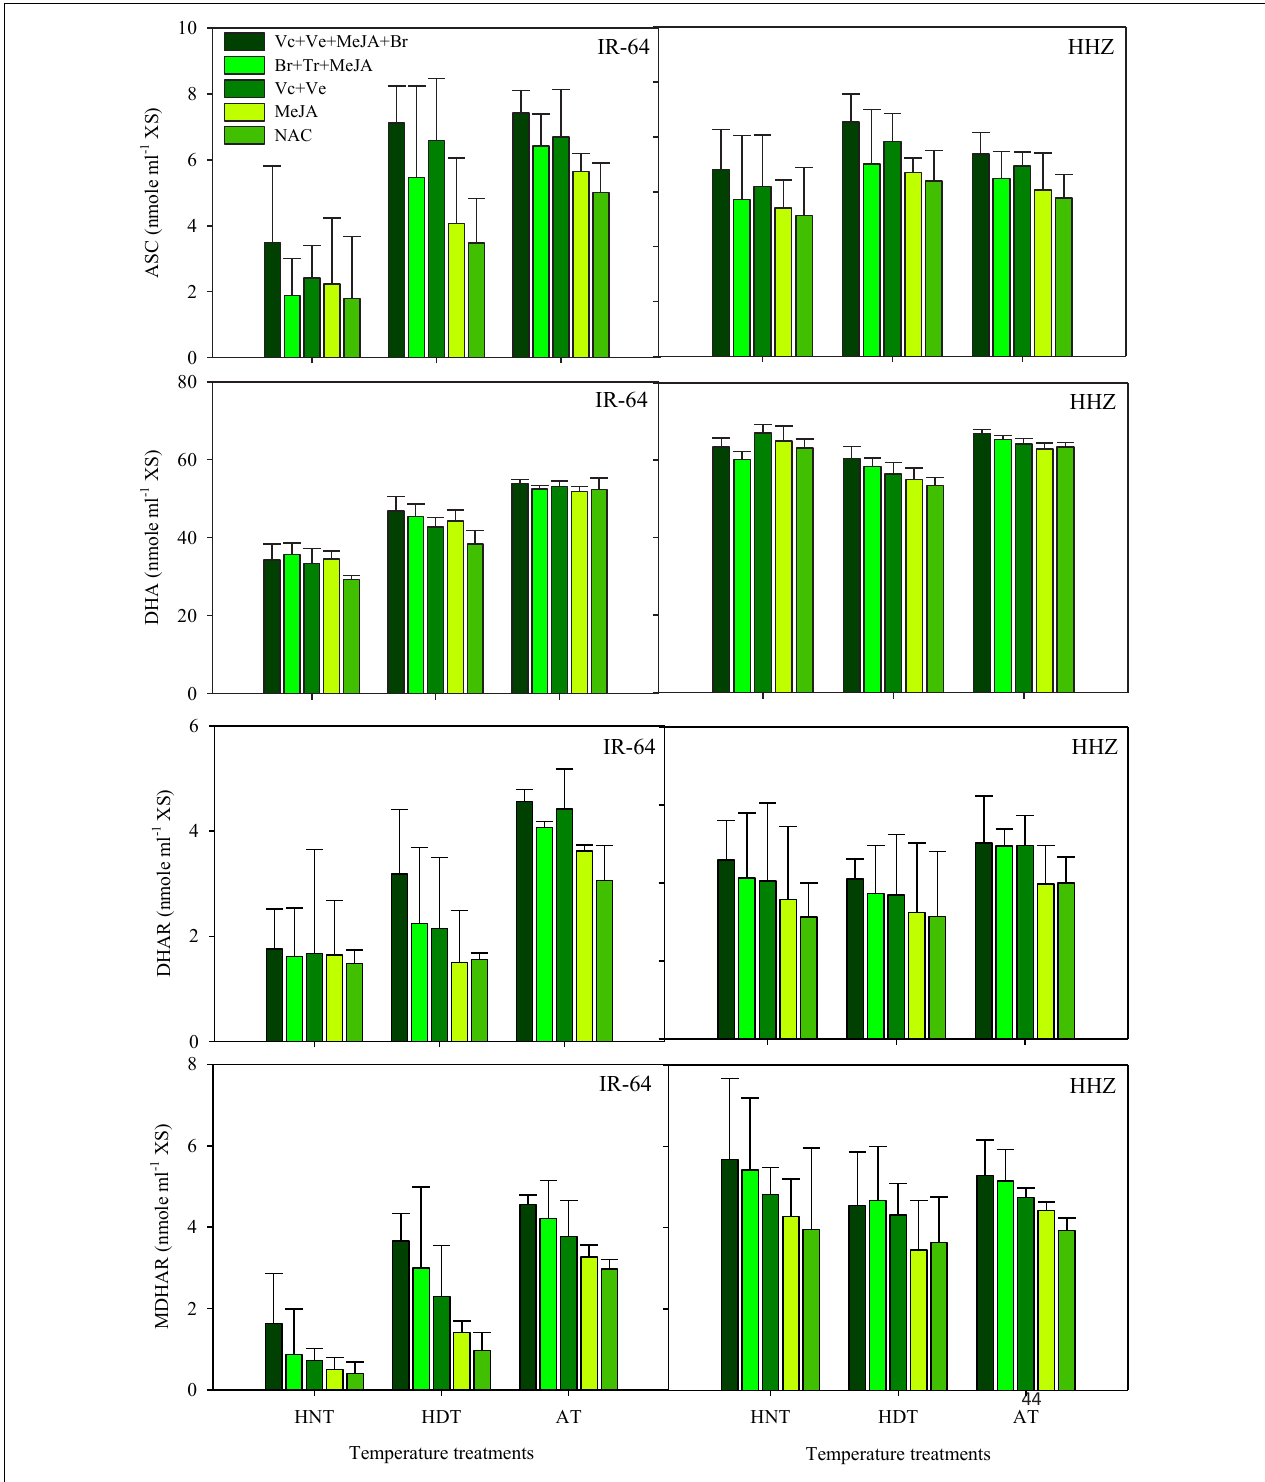
FIGURE 6 | Monodehydroascorbate reductase (MDHAR), dehydroascorbate reductase (DHAR) and dehydroascorbate (DHA) activities in rice xylem sap in response to growth regulators under heat stress. HDT, HNT, and AT stand for high day, high night, and ambient temperature, respectively. The lines on bars represent LSD value for the interaction of PGRs and heat stress (heat stress × PGR) at α = 0.05.